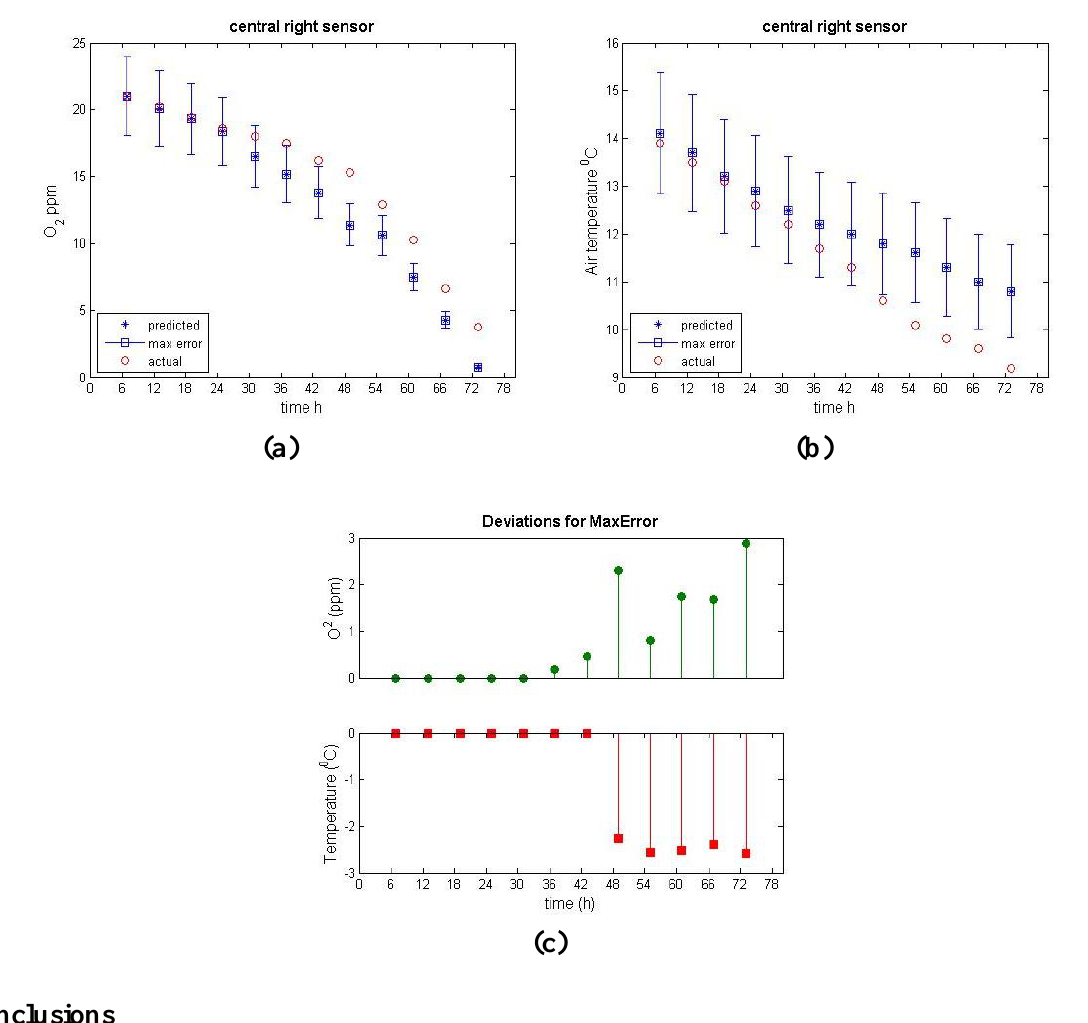
Figure 8. The course of the actual and predicted (with the maximum error incorporated) values of the oxygen concentration (a) and temperature (b) , and the deviations from the maximum error ranges (c)